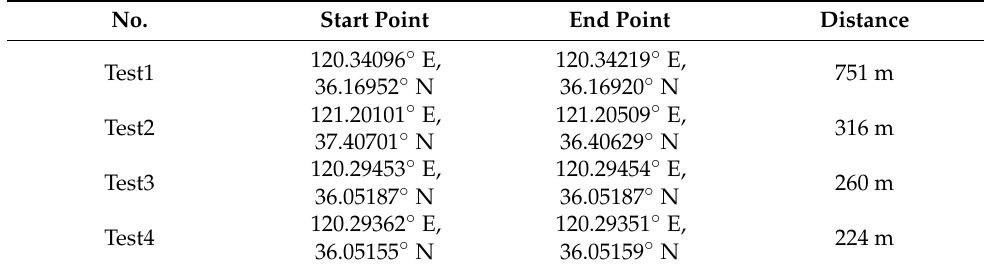
Table 6. Details of AUV field data used in experiments.